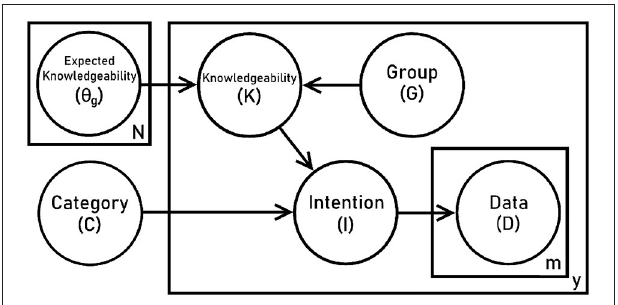
FIGURE 1 | Graphical model for simulating word listening